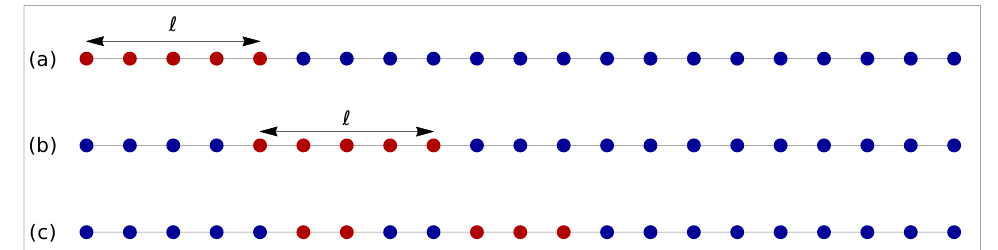
Figure 1: The three subsystem block configurations we consider here. (a) a block of length (cid:96) starting from the boundary. (b) is a block of length (cid:96) at a distance from the boundary. The case (c) shows a disconnected subsystem which does not start from any of boundary